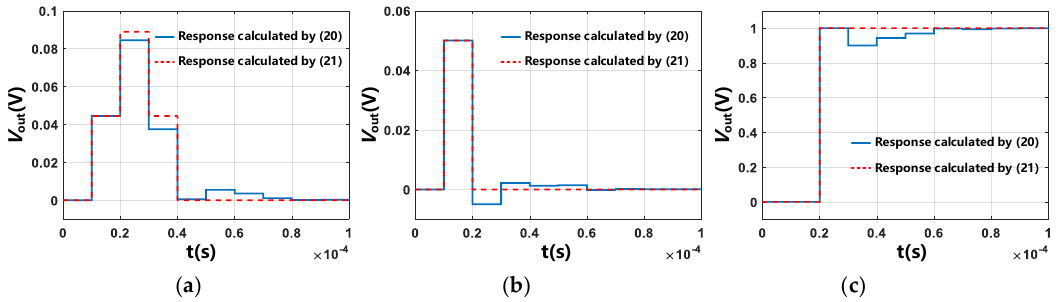
Figure 7. Output voltage transient responses to ( a ) unit R step ( b ) unit v in step (c) unit v ref step.